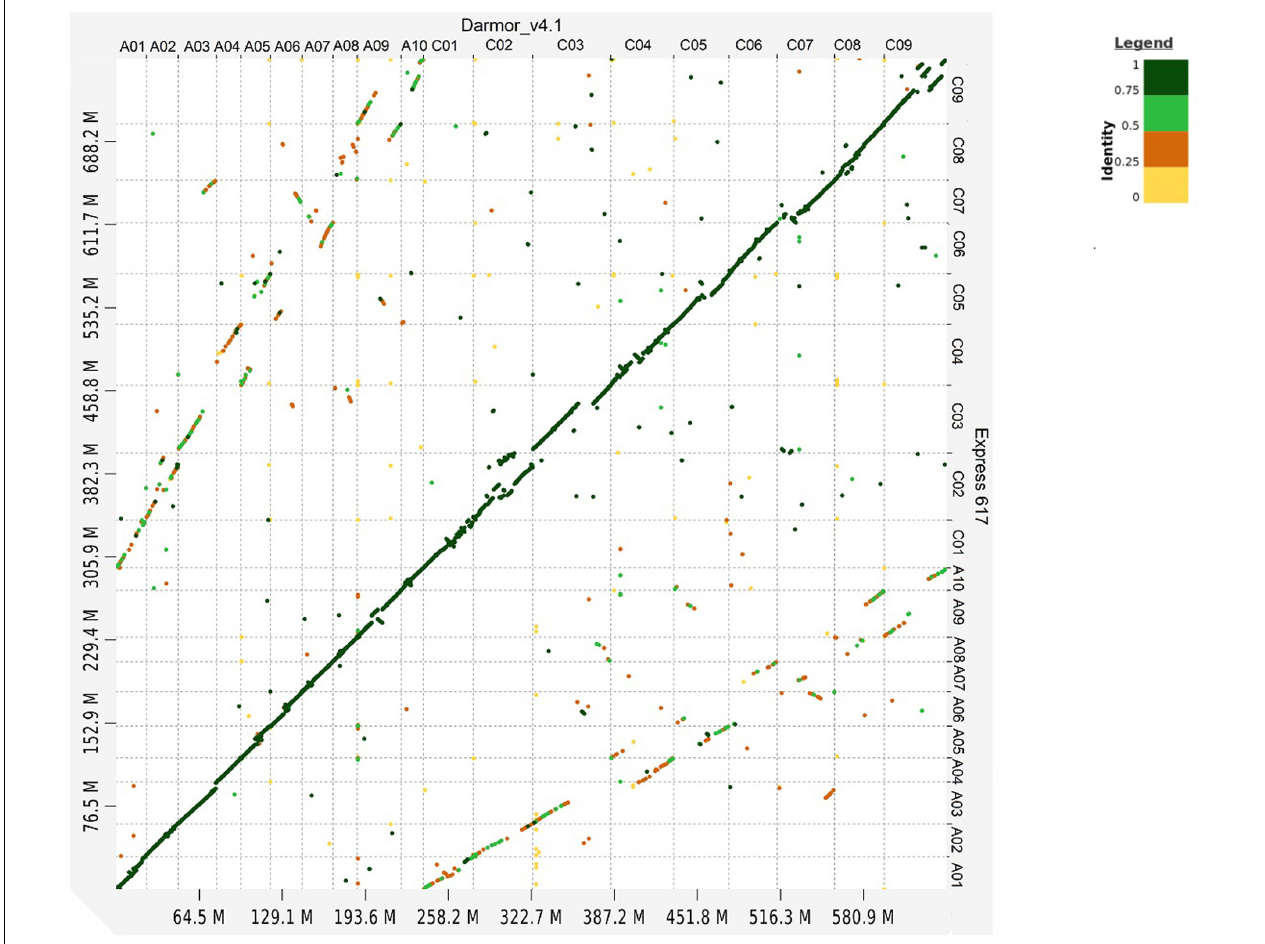
FIGURE 1 | Dot plot comparison between Express 617 and Darmor- bzh v4.1 genome. Sequence similarity is color coded from 0 to